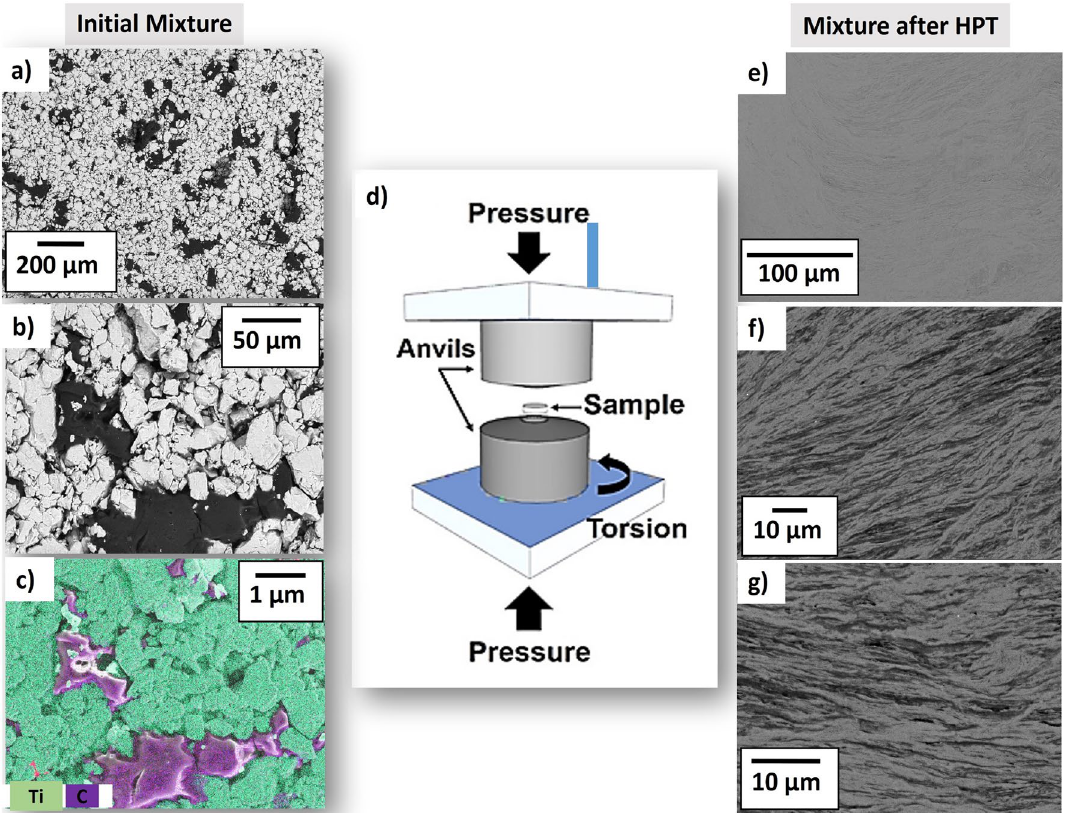
Figure 1. ( a , b ) SEM images in BSE mode and ( c ) corresponding EDS elemental mappings of Ti + 5 vol% BSA before HPT processing. ( d ) Schematic of HPT method and its anvils 29 . ( d , f , g ) SEM images at different magnifications in BSE mode for Ti + 5 vol% of BSA composite after 5 turns of HPT under 2